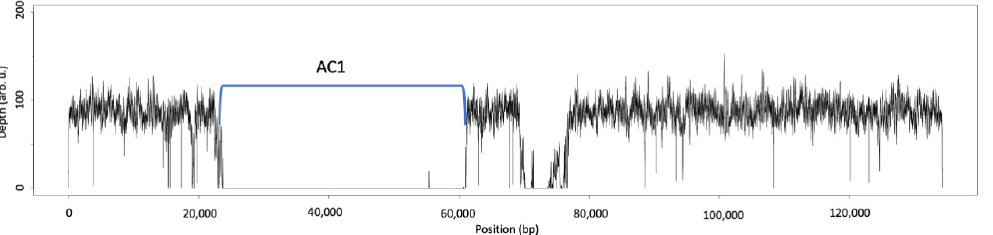
Figure 3. Coverage of accession KL659150 representing the AC1 of IBT 40288 (A-type strain) by sequences derived from IBT 40293 (S-type strain). The AC1 is indicated and reaches from position 24,509 bp ( atr 1) to position 60,118 bp ( atr 14). Note that a short sequence at the left margin of the AC1 is covered by the IBT 40293 sequences.